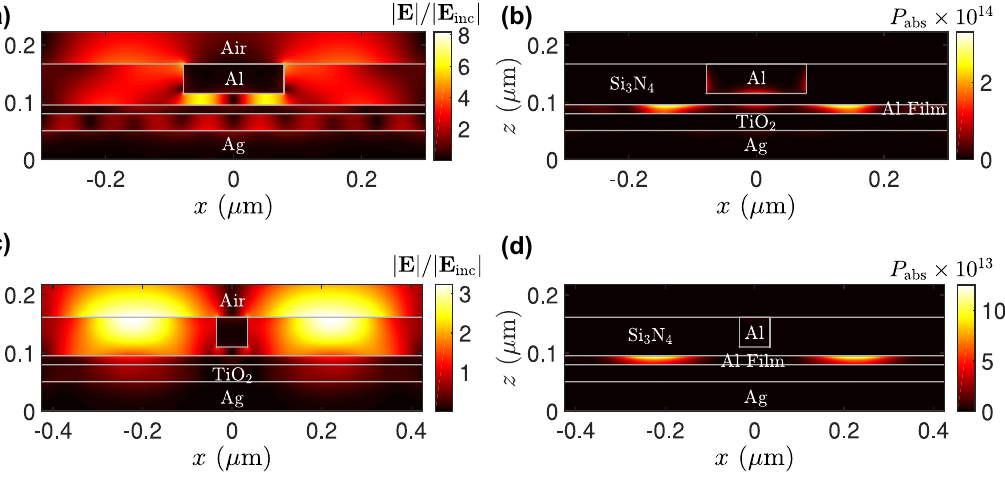
| and power absorption P (W/m 2 ) in a fundamental 1D Al grating in multilayered inc abs = 638.9 nm: (a) and (b) are for Λ = 600 nm, whereas (c) and (d) are for Λ = 850 0 values shown in Figure 2. The FF and t are 0.26 and 21 nm (0.08 and planar − Al gap